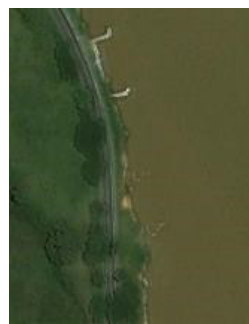
Figure 16. Cauca River, Guarumo: directional spurs around the 40 m long defense as a left bank protection (Source: BING Maps Aerial).